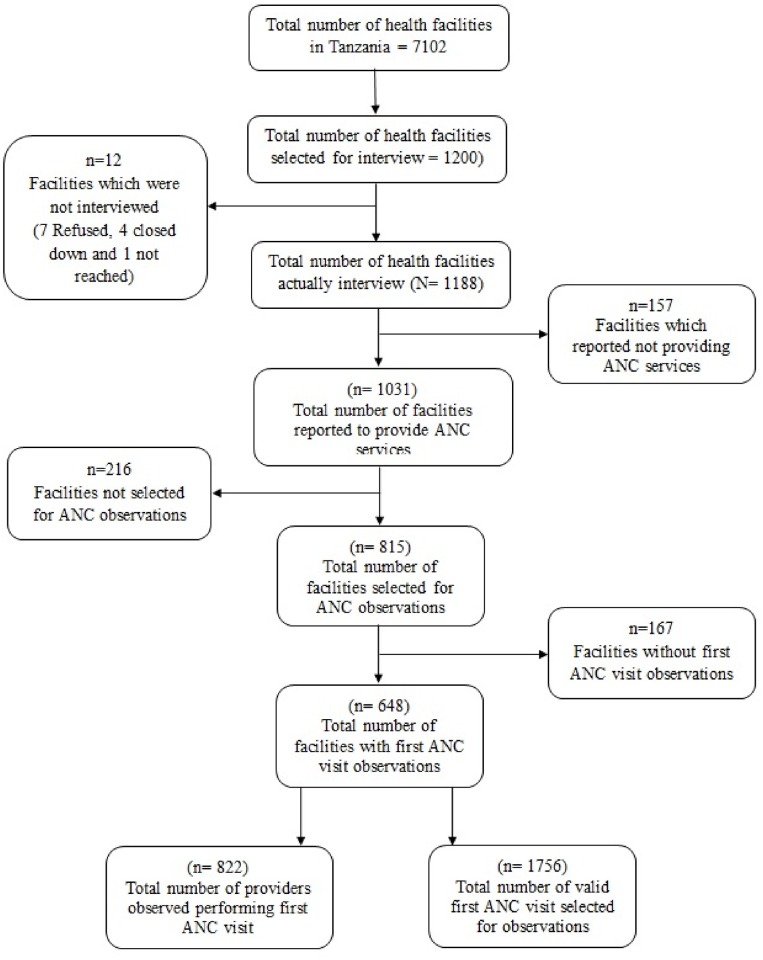
Selection procedure for the sampling units included in this analysis.